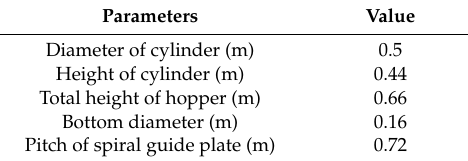
Table 2. Geometric parameters of the hopper.